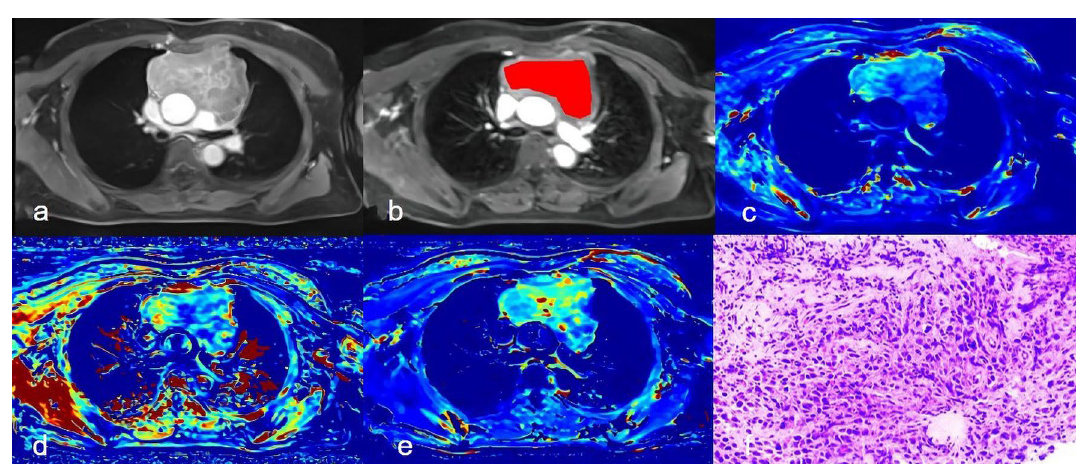
Figure 2. A 52-year-old female with Hodgkin’s lymphoma ( a ) Axial position of dynamic enhanced scan showed anterior mediastinal mass, and uneven enhancement of the lesion after enhancement; ( b ) Delineated the lesion; ( c - e ) Correspond to the generated Ktrans Map, Kep Map, and Ve Map; ( f ) Pathological sections (HE staining, 200 times